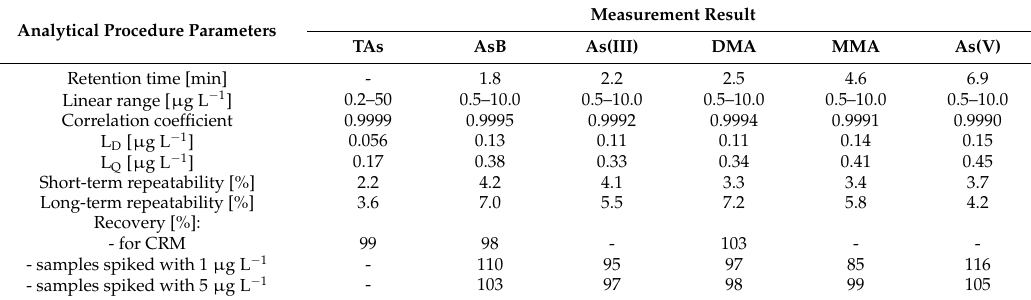
Table 3. Characteristics of developed analytical procedures for total arsenic and arsenobetaine, arsenite(III), dimethylarsenic acid, monomethylarsenic acid and arsenate(V) determination in freshwater fish samples by inductively coupled plasma mass spectrometry with dynamic reaction cell and high performance liquid chromatography inductively coupled plasma mass spectrometry with dynamic reaction cell,